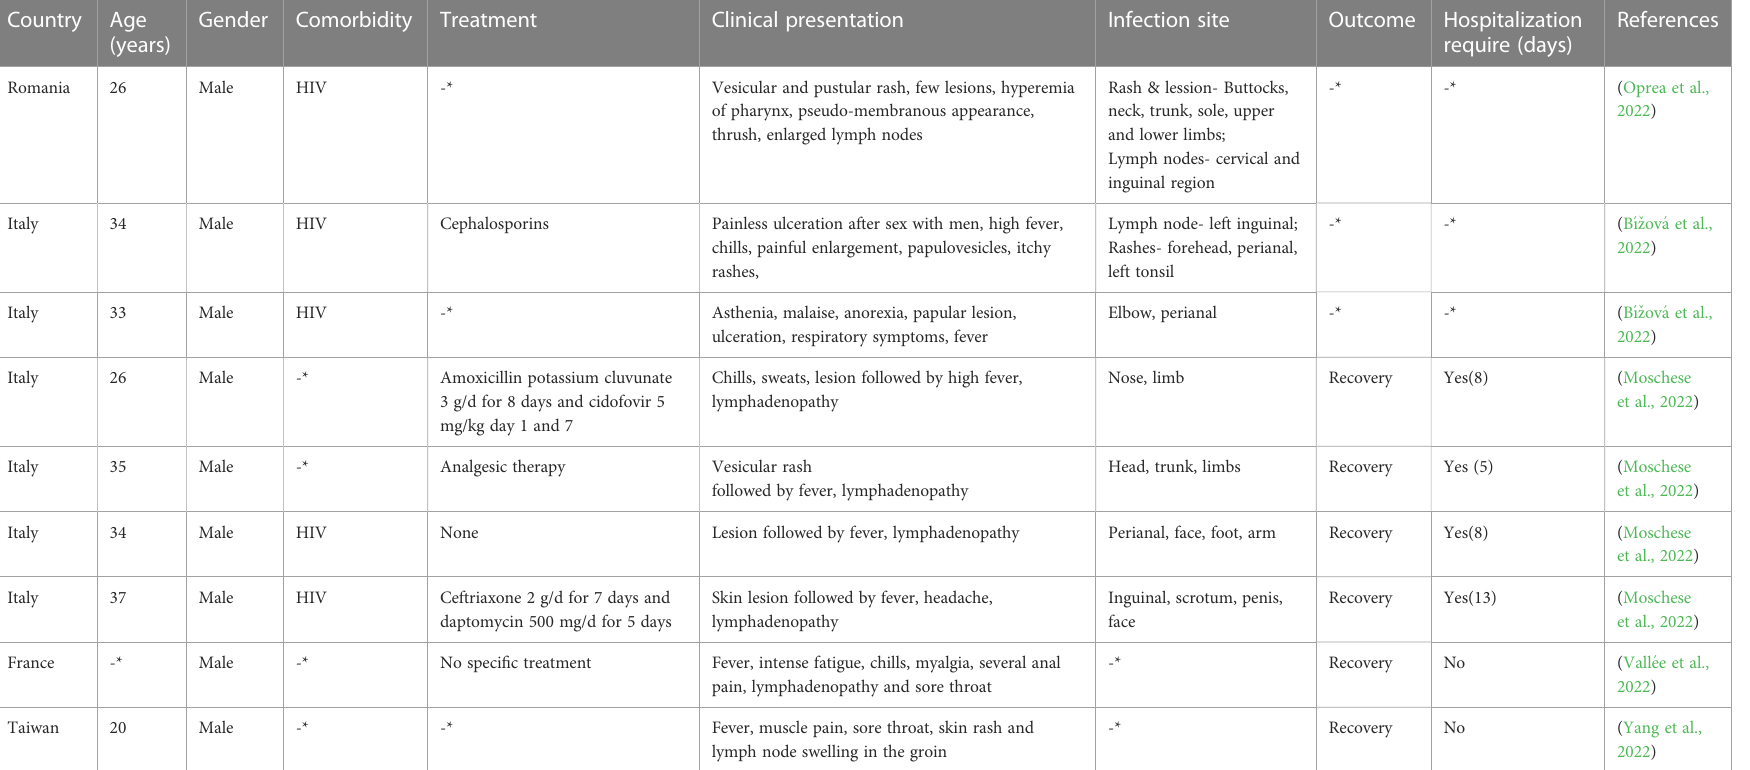
TABLE 2 Overview of the clinical course and outcome of cases from recent outbreak of